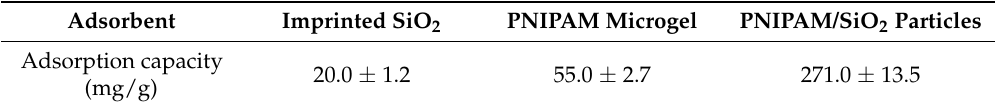
Table 1. Adsorption of phosphate anions by different adsorbents (pH = 7, 15 ◦ C).